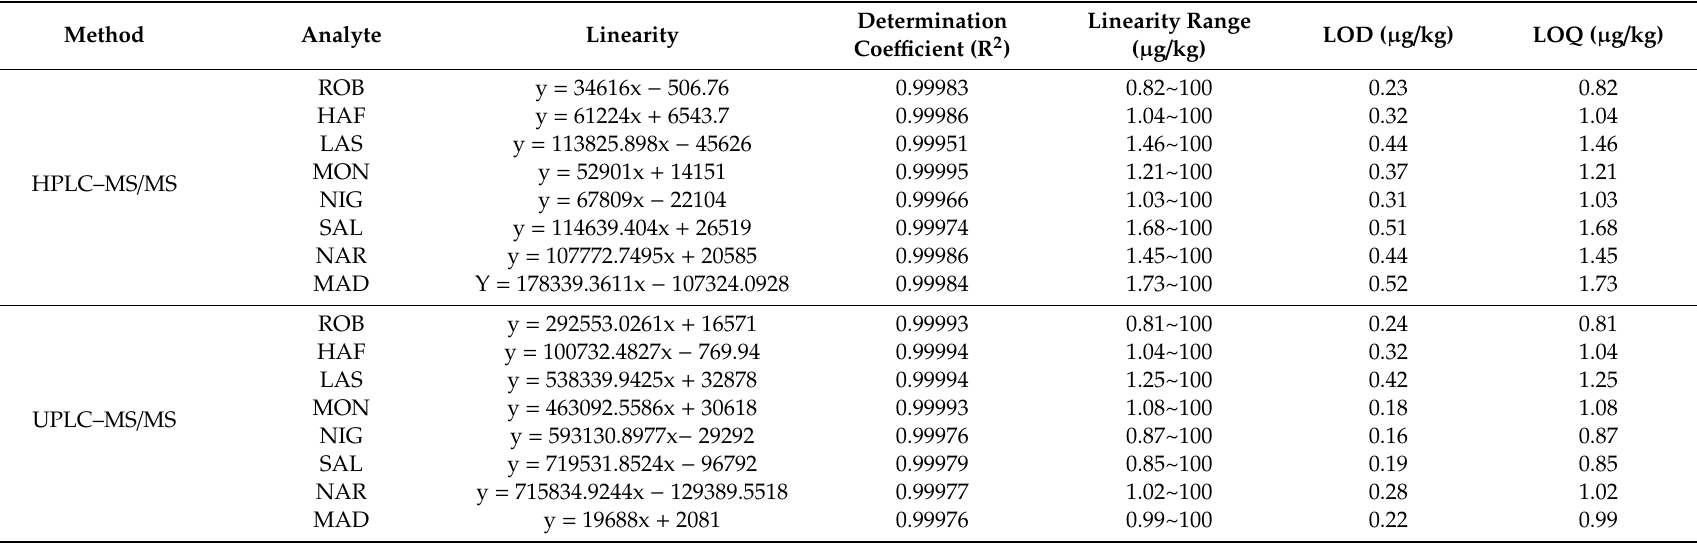
Table 2. Linearity, determination coe ffi cient, LODs, and LOQs for the analysis of eight coccidiostats in egg